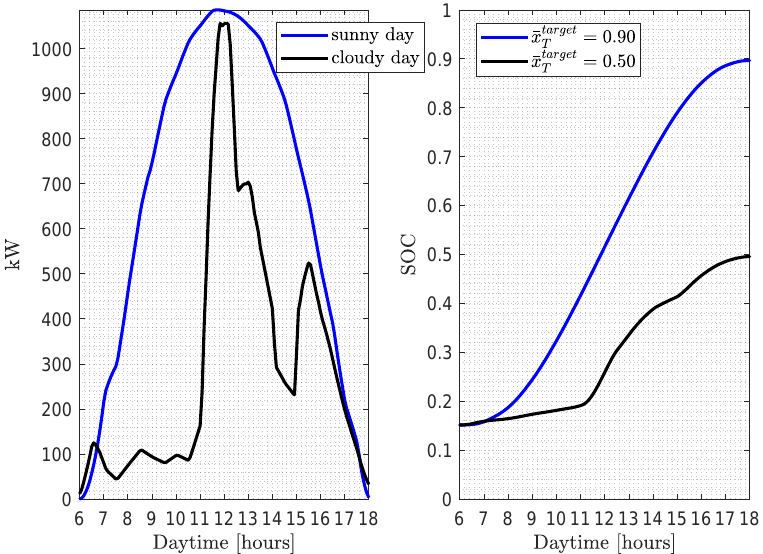
Figure 3. Daily solar power curves ( u W ) for charging 400 BEVs and mean target SOC trajectories ( x target ) broadcasted by the parking lot operator. t